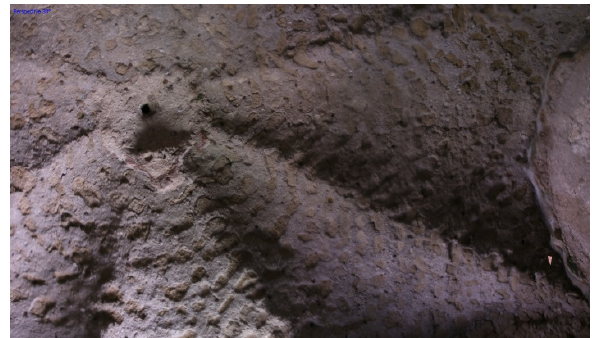
Figure 4. Detail view of the textured